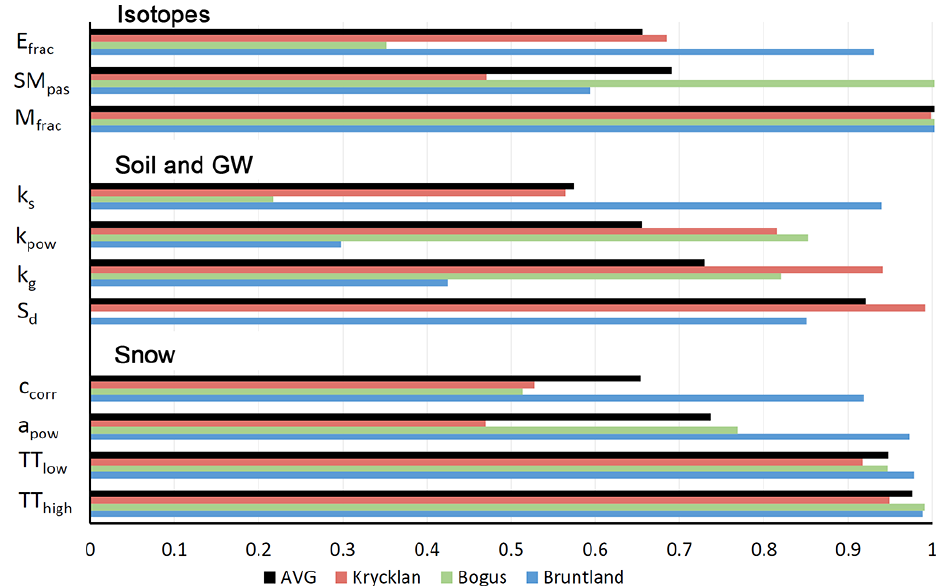
Figure 10. Sensitivity of model parameters shown as ratio of pre- and post-calibration standard deviation – the smaller the ratio, the more constrained the post-calibration parameter interpreted as parameter sensitivity. The parameters are grouped by model modules and organized within modules from most sensitive to least sensitive based on average for all experimental